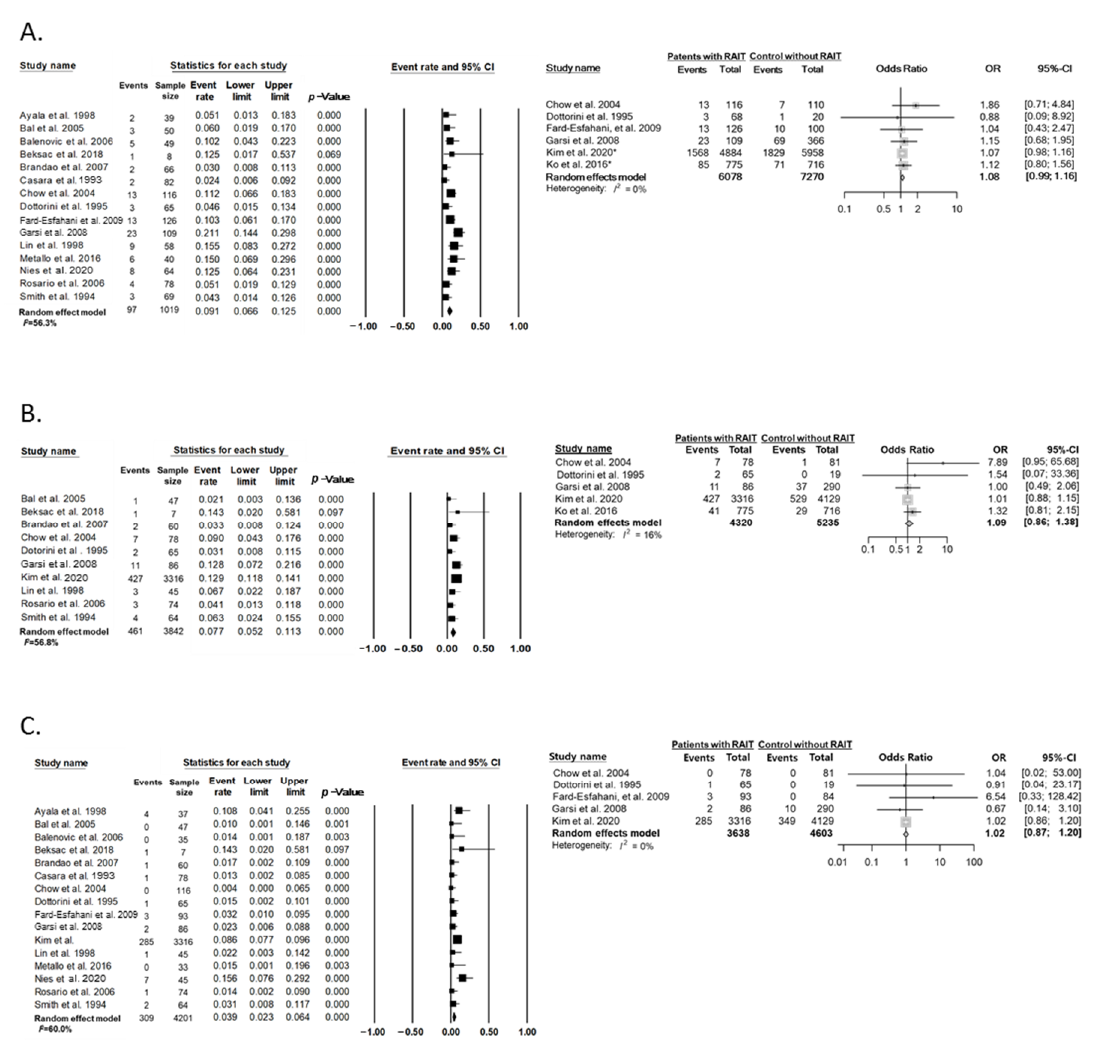
Figure 5. Effect of RAIT on adverse pregnancy outcomes. ( A ) Miscarriage or abortion, ( B ) preterm labor, and ( C ) congenital anomalies. * The study was classified as a case series design because one arm data of patients with thyroid cancer was used in the study. Studies referenced: [14,20,22,26,28–36,38–41].